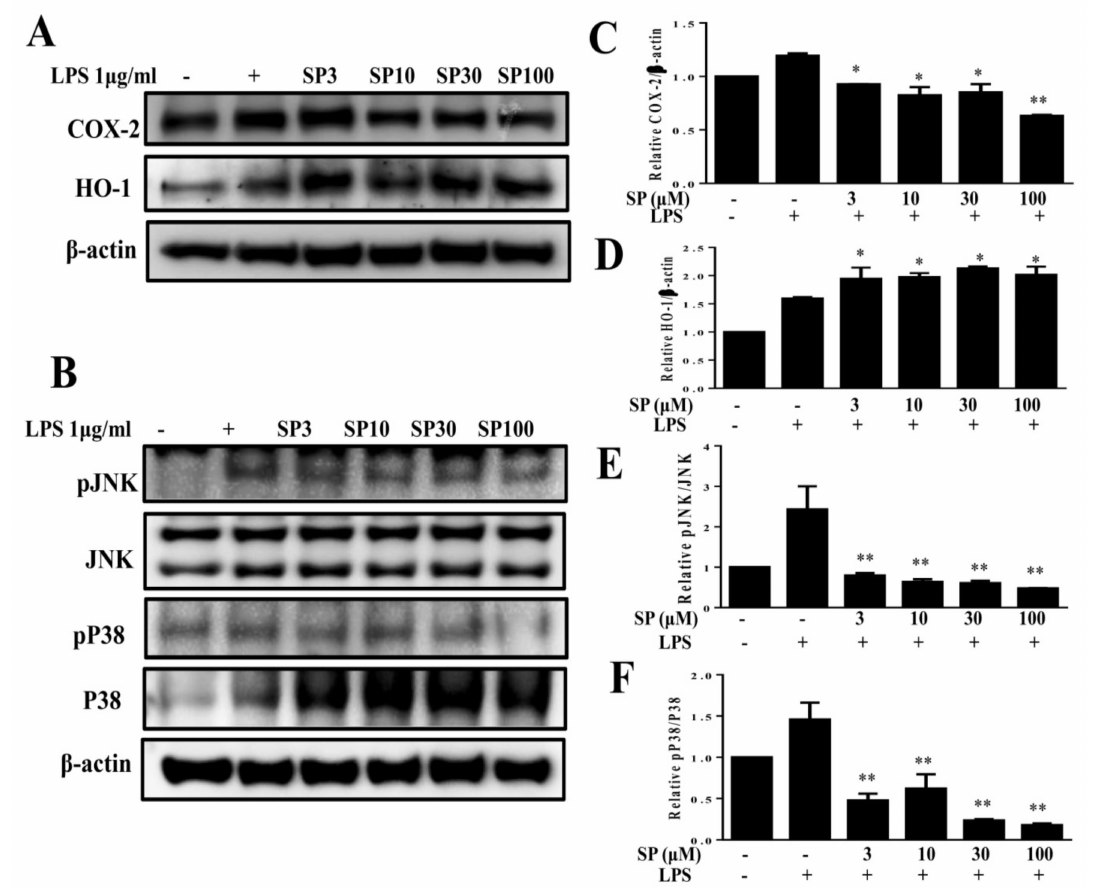
Figure 4. Spilanthol (SP) decreased cyclooxygenase-2 (COX-2), enhanced heme oxygenase-1 (HO-1) protein expression, and inhibited phosphorylation of mitogen-activated protein kinase (MAPK) in LPS-induced 3T3-L1 pre-adipocytes. Here, 10 4 cells / mL were pretreated with 3–100 µ M SP for 1 h and cultured with LPS (1 µ g / mL) for 24 h. ( A ) Western blots of COX-2 and HO-1, ( B ) pJNK, JNK, pP33, and P38 proteins ( n = 3 per group). β -Actin was used as an internal control. ( C ) The relative protein levels of COX-2, ( D ) HO-1, ( E ) pJNK / JNK, and ( F ) pP38 / P38. Data are presented as means ± SD; * p < 0.05, ** p < 0.01 compared to di ff erentiated 3T3-L1 cells alone (control group). None: pre-adipocytes; control: di ff erentiated adipocytes; SP3: di ff erentiated adipocytes + 3 µ M SP; SP10: di ff erentiated adipocytes + 10 µ M SP; SP30: di ff erentiated adipocytes + 30 µ M SP; SP100: di ff erentiated adipocytes + 100 µ M